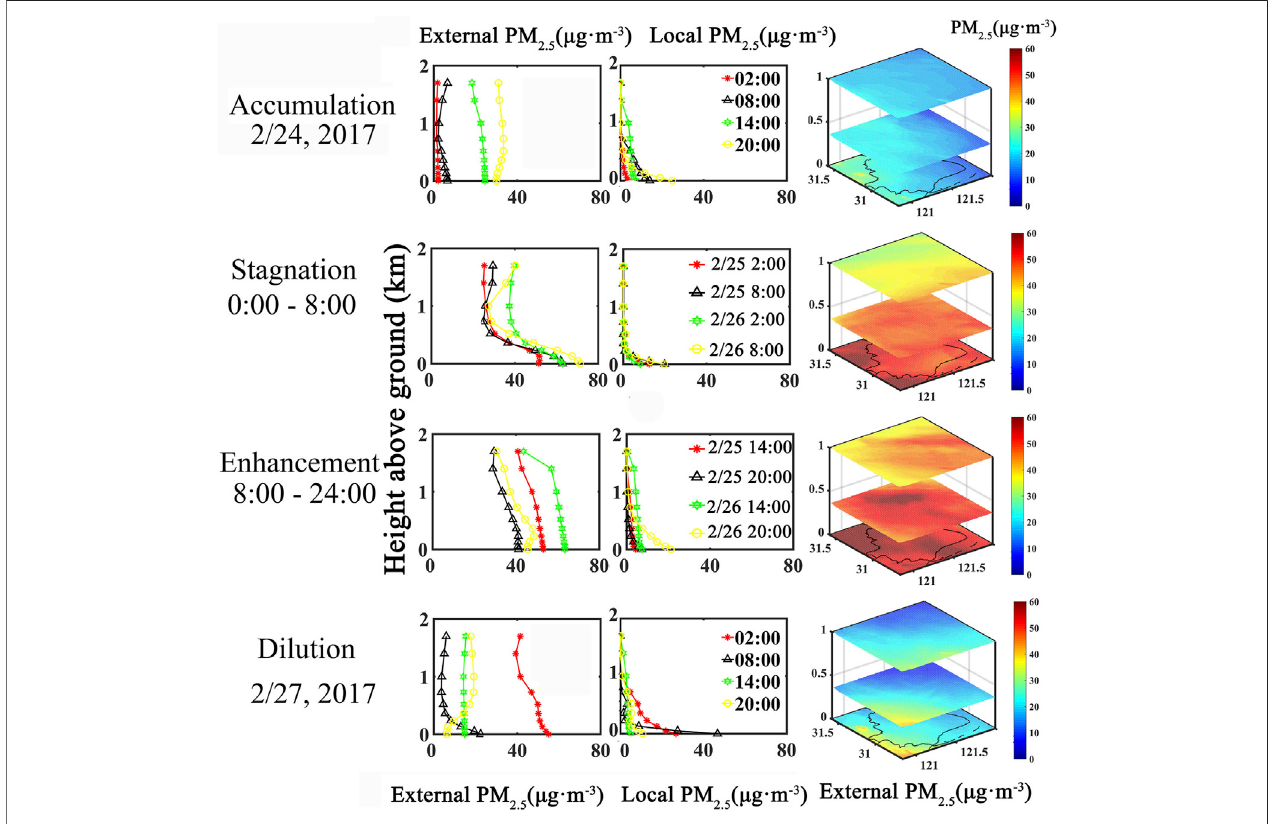
FIGURE 7 | Simulated local and external PM2.5 vertical pro fi les and vertical spatial distribution in four different stages in February 24 – 27, 2017.